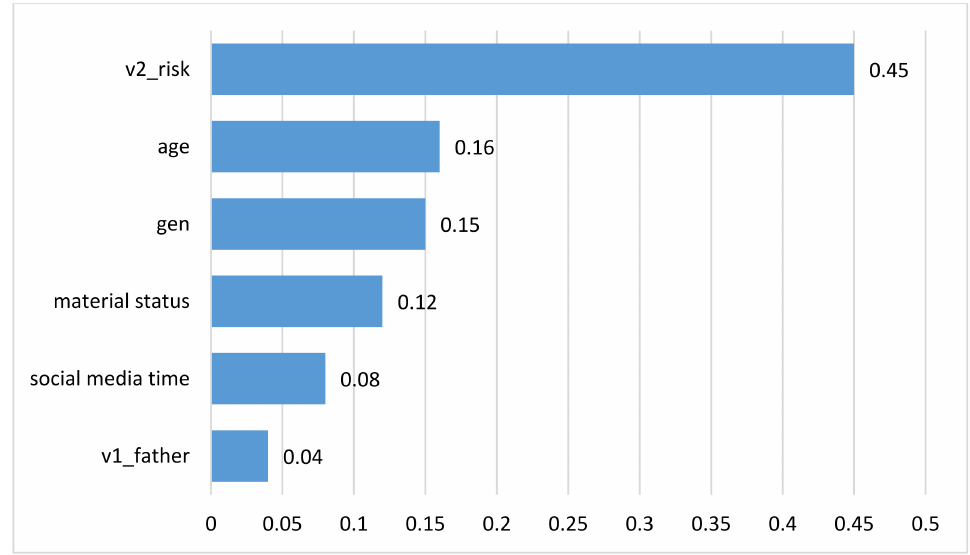
Figure 6. Independent